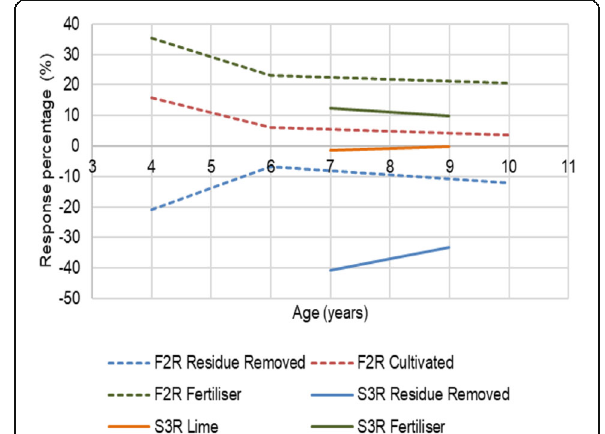
Fig. 4 Relative response compared to the control treatment over time for site preparation and fertilisation in the second rotation (F2R) established in 1971 (dotted lines) and third rotation (S3R) on same three sites established in 1991 (solid